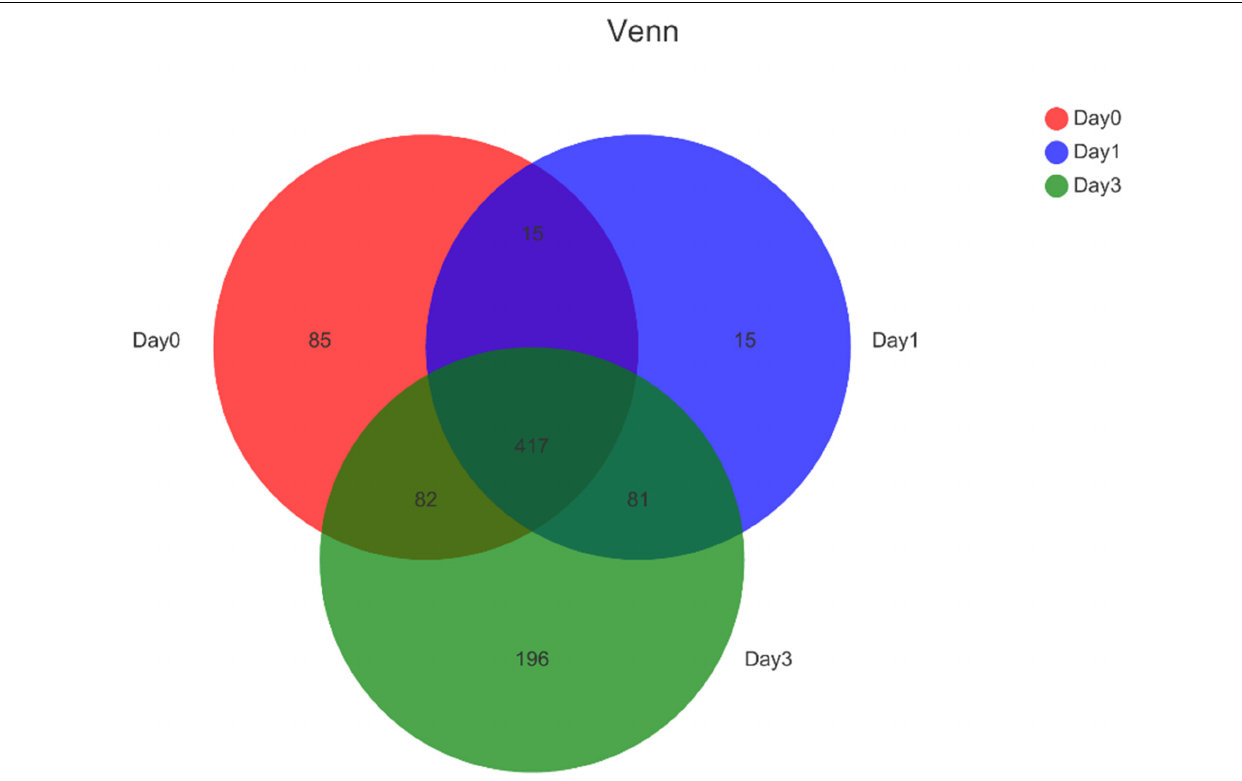
FIGURE 2 | Venn diagram for bacterial genera composition in clam at different storage time. Numbers in different region refers to the number of specific or common genera in different sample group. The sum of numbers in each circle refers to the total genera annotated at each storage time.